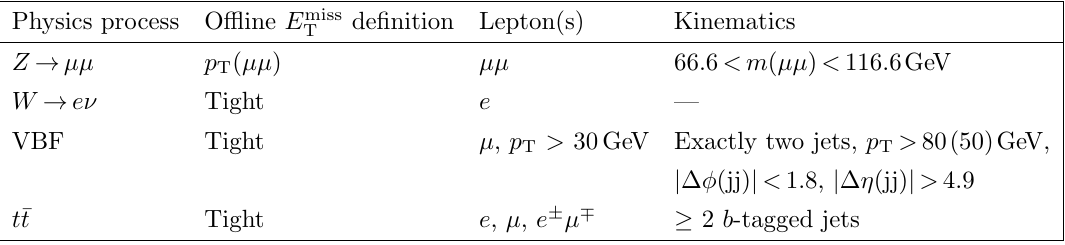
Table 4. De(cid:12)nition of o(cid:15)ine analysis selections used for e(cid:14)ciency measurements, labelled by the physics process being examined. All indicated lepton requirements implicitly require p T ( ‘ ) > 25 GeV unless speci(cid:12)ed. The o(cid:15)ine E miss de(cid:12)nitions correspond to di(cid:11)erent working points. When multiple T jets are required with di(cid:11)erent p T thresholds, the threshold for the subleading jet is listed in parentheses, e.g. 80 (50)